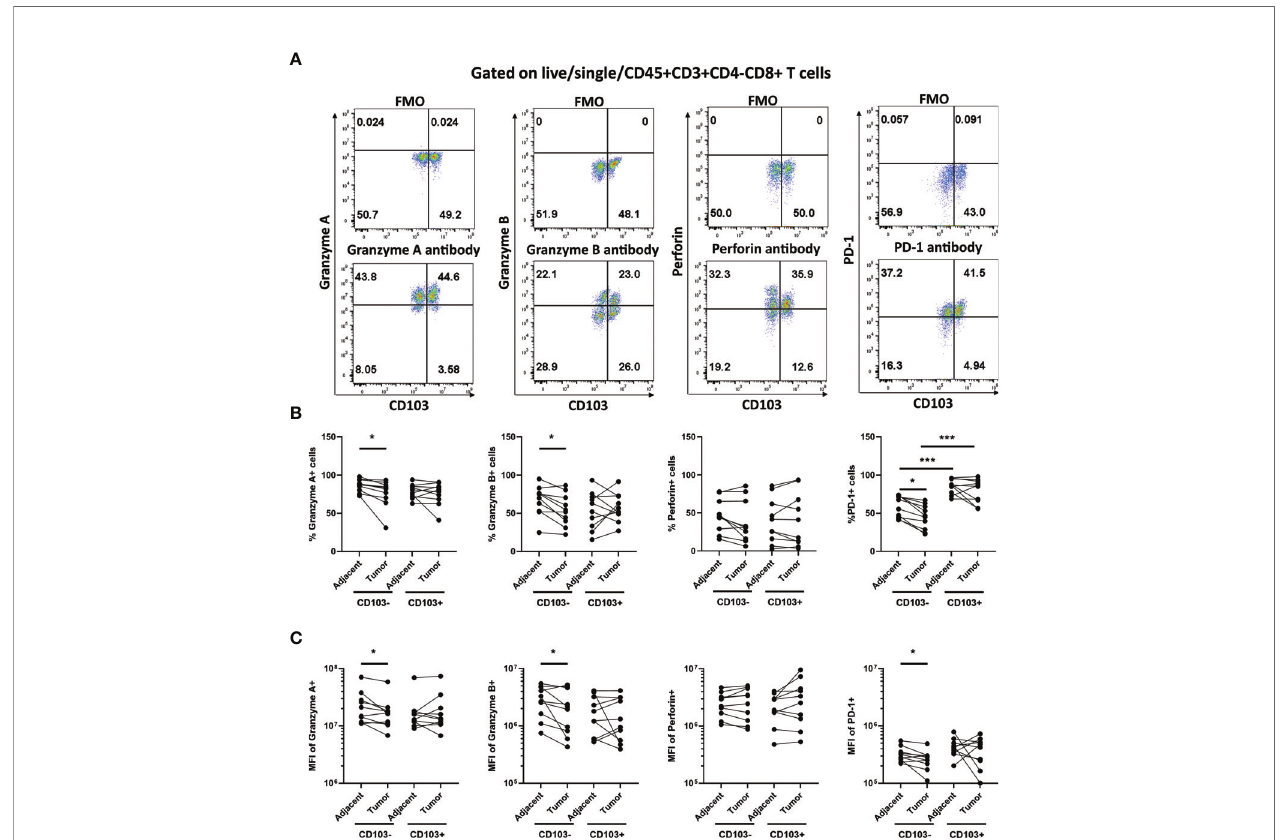
FIGURE 3 | Granzyme A and B, and PD-1 Expression is Suppressed in Endometrial Carcinoma CD103-CD8+ T cells. The expression of Granzyme A, Granzyme B, Perforin, and PD-1 by CD103- and CD103+ CD8+ T cells from endometrial carcinomas and adjacent non-cancerous endometrium was determined by fl ow cytometry. Representative fl ow cytometry gating is indicated in panel (A) . Data is presented as percentage of positive cells (B) or mean fl uorescence intensity (MFI) (C) . Each circle represents an individual patient. ( n=9 ). *p<0.05; ***p<0.001. Wilcoxon matched-pairs signed rank